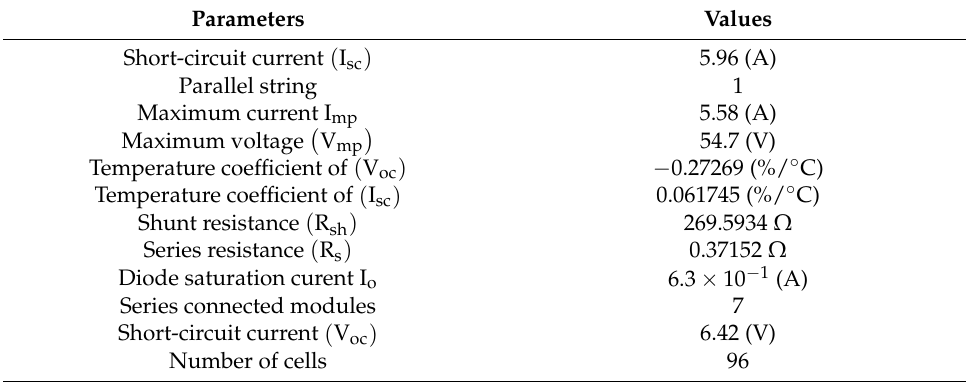
Figure 13. The graphical user interface of the reactive-power profile. Table 1. Parameters of